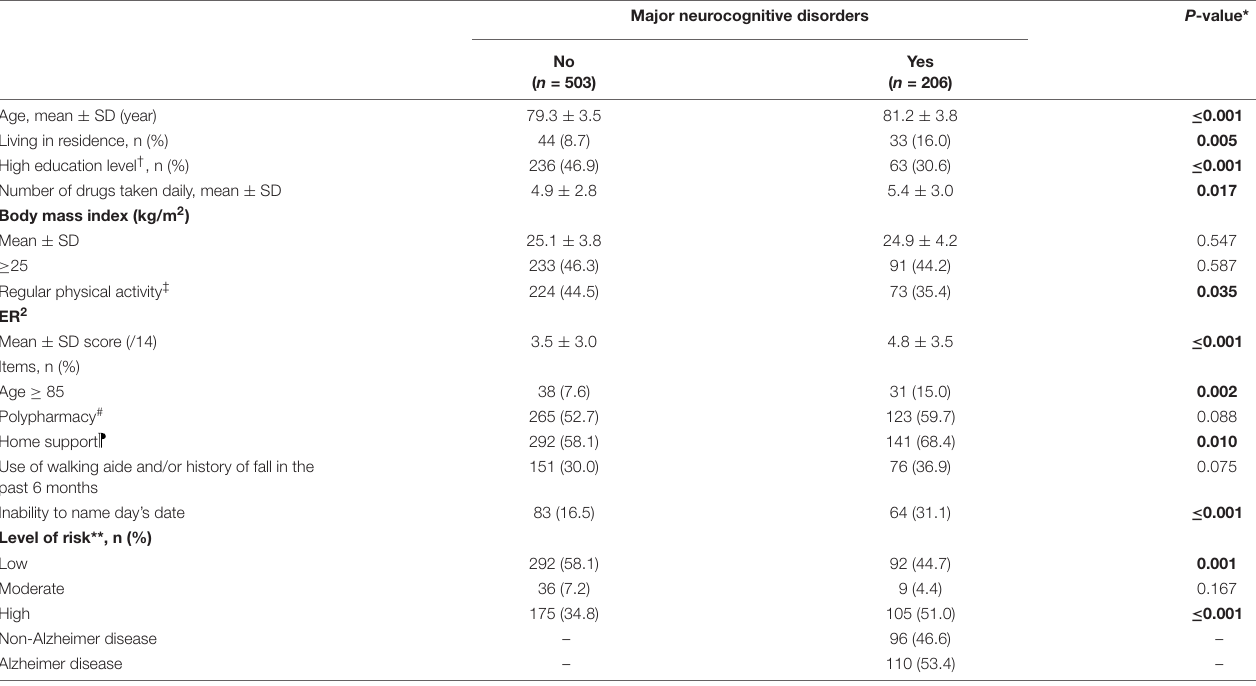
TABLE 1 | Comparisons of participant’s baseline characteristics and incident major neurocognitive disorders according to their cognitive status at the end of the 7-year follow-up ( n =